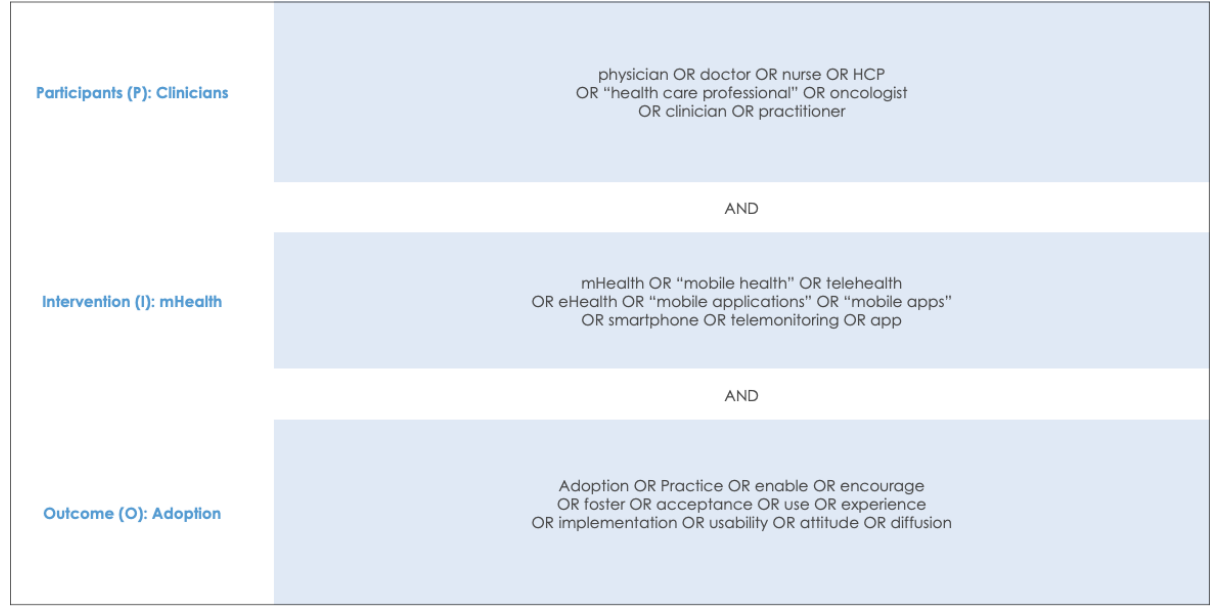
Figure 1. The search string according to the participants, intervention, comparator, and outcome (PICO) framework. mHealth: mobile